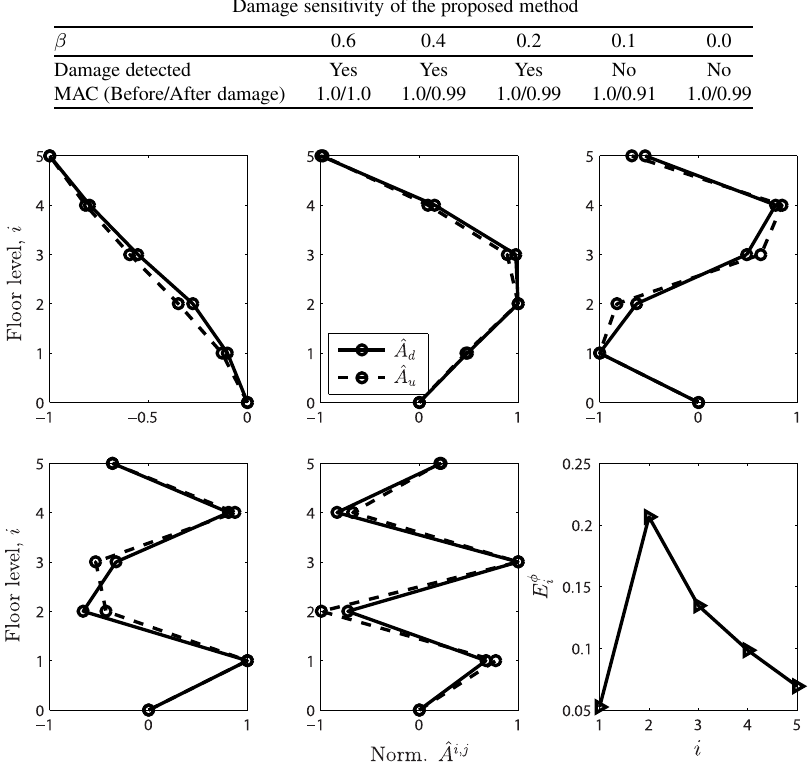
Fig. 11. Difference in mode shapes due to change in the inter-storey stiffness between 2 nd and 3 rd floor ( α = 25%